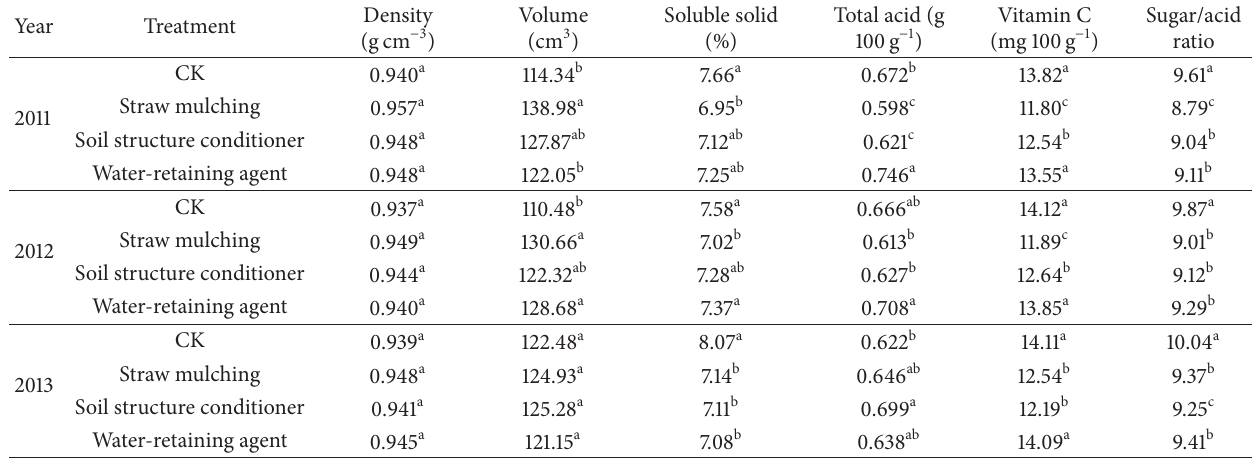
Table 3: Main quality indexes of tomato fruit. Columns with the same letter represent values that are not significantly different at the 0.05 level of probability according to the Duncan’s multiple range test.